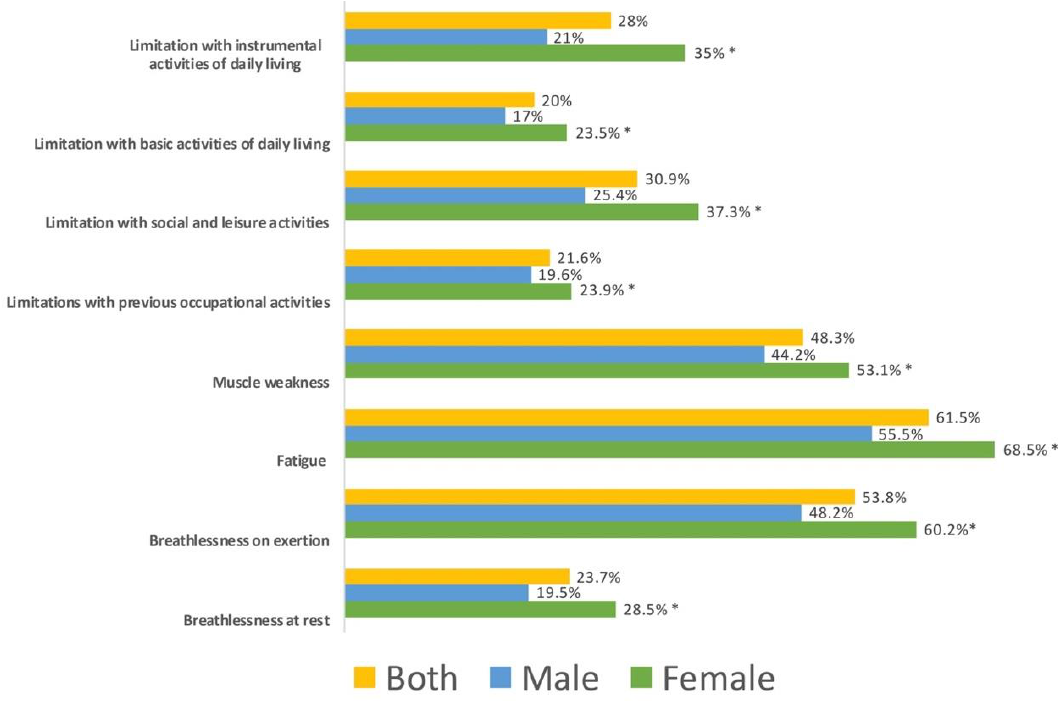
Figure 1. Distribution of the percentage of women and men exhibiting limitations on each item of the Functional Impairment Checklist (FIC). * Significant differences between men and women ( p < 0.01).